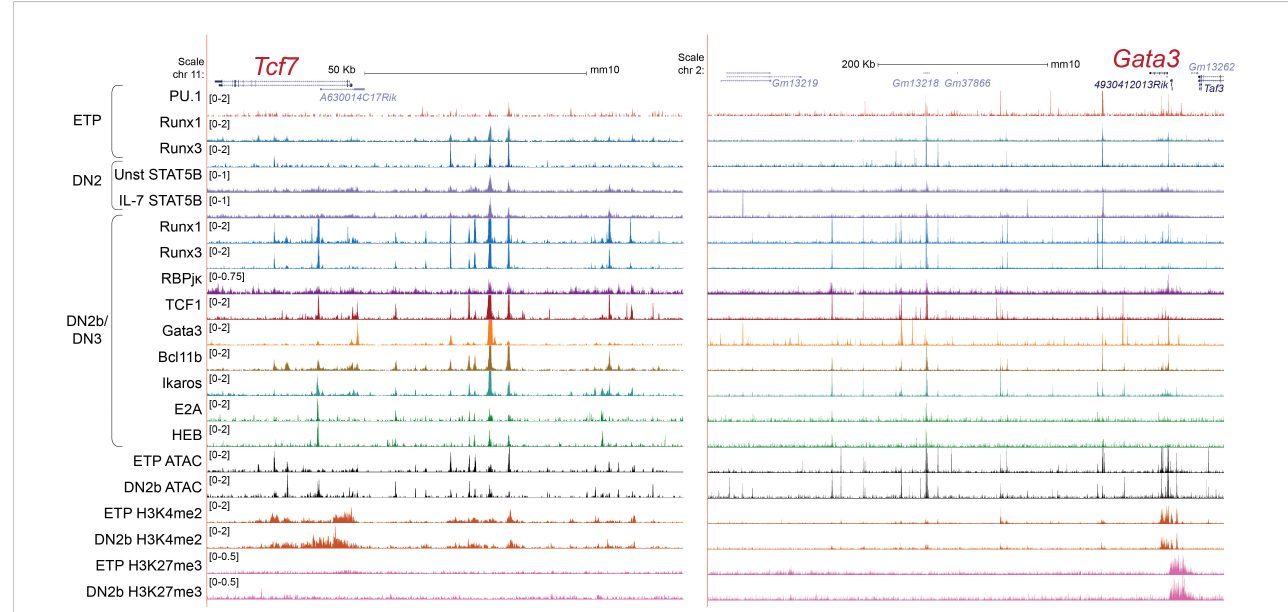
FIGURE 3 Transcription factors and chromatin state markers in Tcf7 and Gata3 enhancer regions. UCSC genome browser tracks show transcription factor occupancy, histone markers, and chromatin accessibility pro fi les near the Tcf7 locus (left) and Gata3 locus (right) in the indicated stage (67, 84, 93, 101, 133, 134). H3K4me2 represents active enhancers and H3K27me3 marks repressive chromatin regions. Unst STAT5B: unstimulated STAT5B, IL-7 STAT5B: IL-7 stimulated